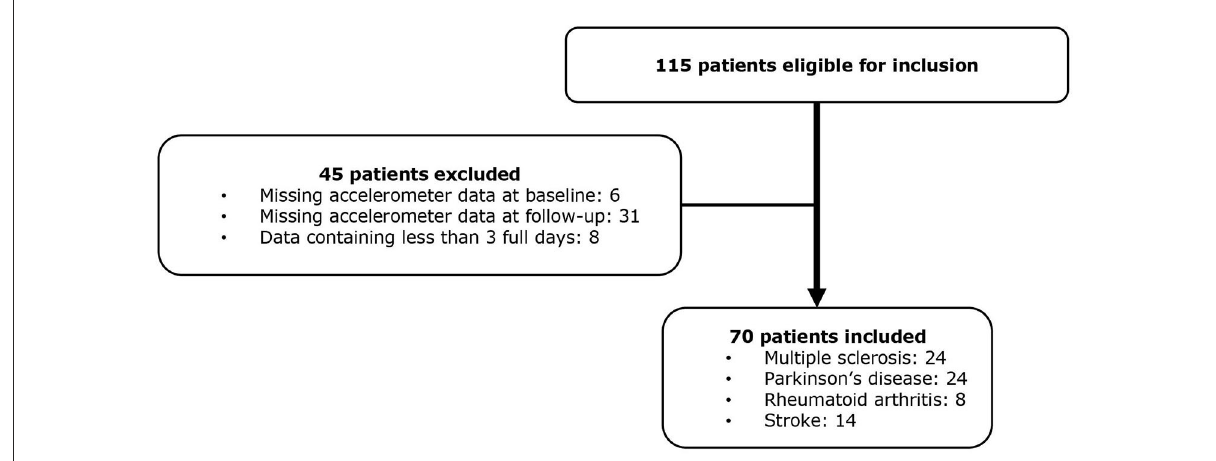
FIGURE1 Flow chart of included